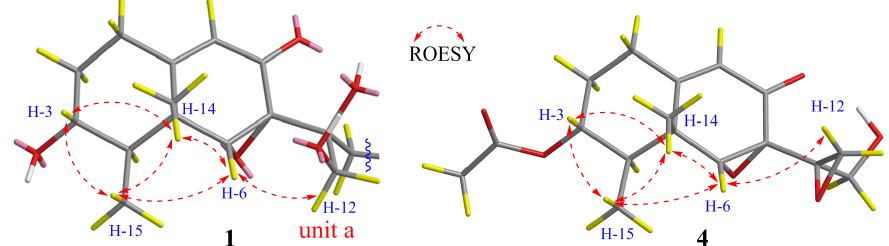
Figure 2. Key HMBC and 1 H- 1 H COSY correlations of compounds 1 – 4 .